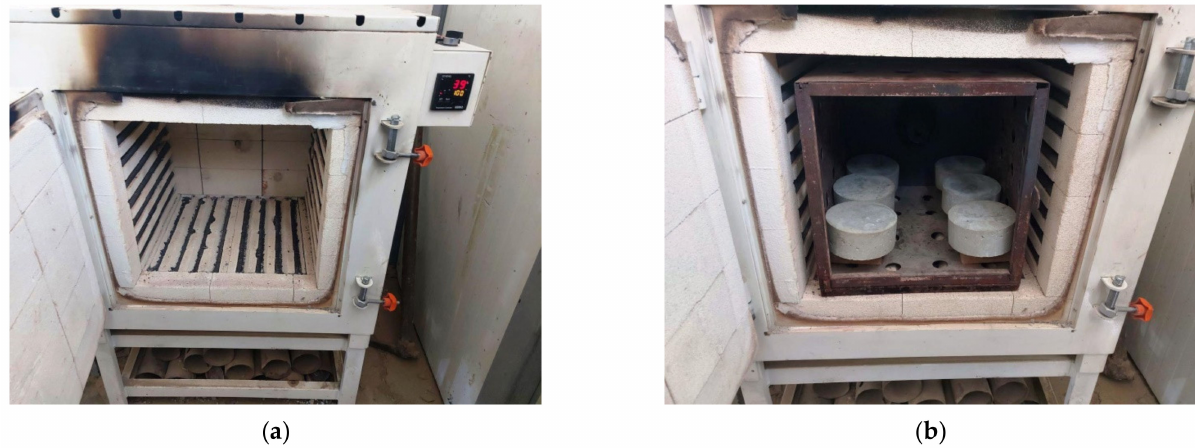
Figure 4. The electrical furnace ( a ) furnace interiors; ( b ) specimens